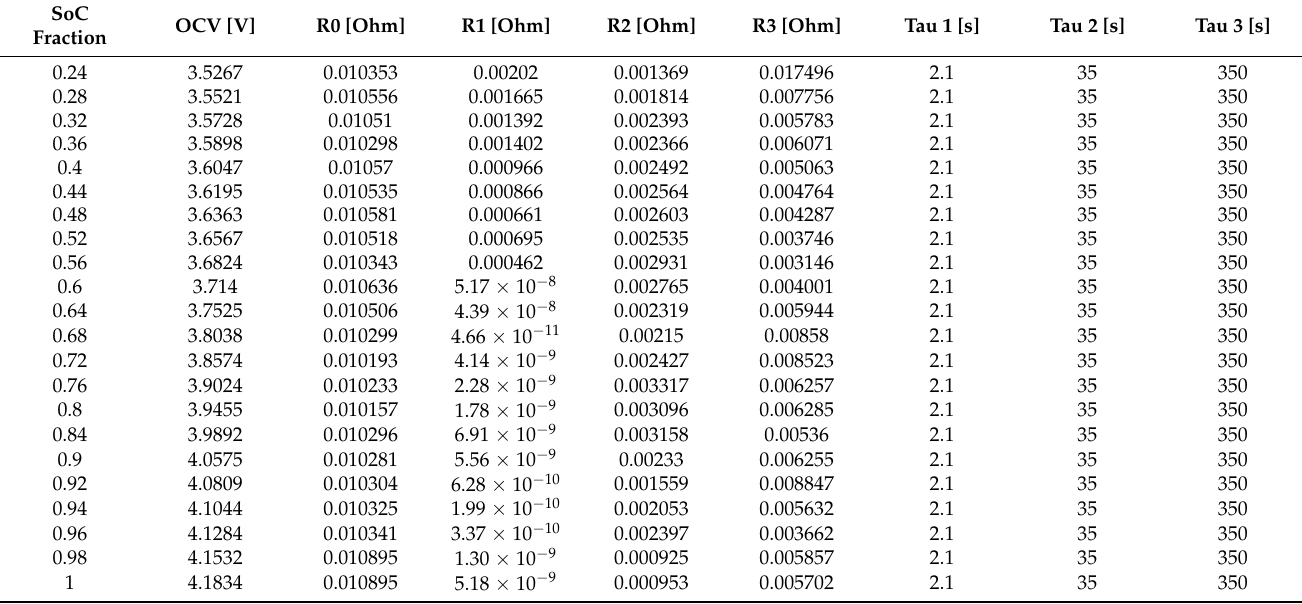
Table A3. ECM results from AMPP in a climate chamber at 10 ◦